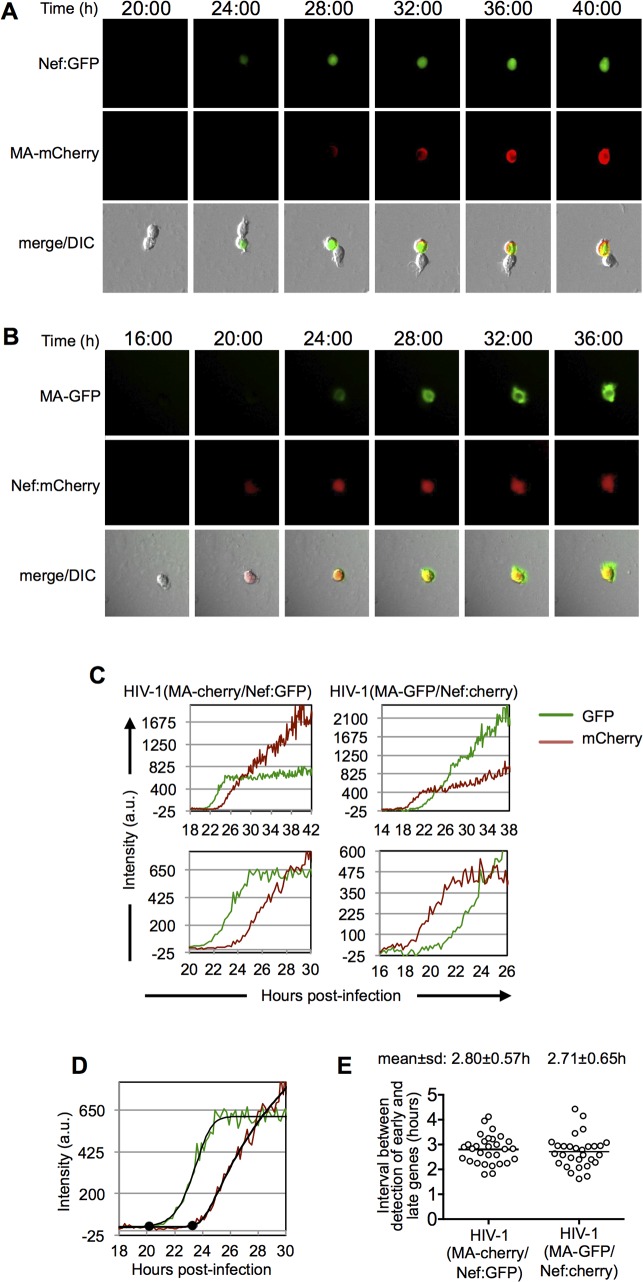
Dynamics of early and late gene expression in individual cells.(A and B) Examples of images of individual MT-4 cells infected with HIV-1(MA-cherry/Nef:GFP) (A) and HIV-1(MA-GFP/Nef:cherry) (B) dual-reporter virus. The time post-infection (in hours) is indicated at the top of the image sets. (C) Examples of quantitation of fluorescent intensities for individual cells infected with HIV-1(MA-cherry/Nef:GFP) and HIV-1(MA-GFP/Nef:cherry) dual-reporter viruses. Intensity units are 12-bit grey-level values, from 0–4095. Upper panels show data from entire experiments, lower panels show a magnified portion of the data around the time that early and late gene expression became detectable. (D) Example of a 5-parameter logistic curve fit to the raw data and time points at which early and late gene expression is detected, defined here as the first point at which the fit-curve rises 7 intensity units above its lower bound. The black dots indicate the identified time points for the detection of early and late gene expression. (E) Time interval between the detection of early and late gene expression, as defined in (D) for 30 individual HIV-1(MA-cherry/Nef:GFP) infected cells and 29 individual HIV-1(MA-GFP/Nef:cherry) infected cells. Fluorescence data for each of these individual cells is shown in S2 and S3 Figs.